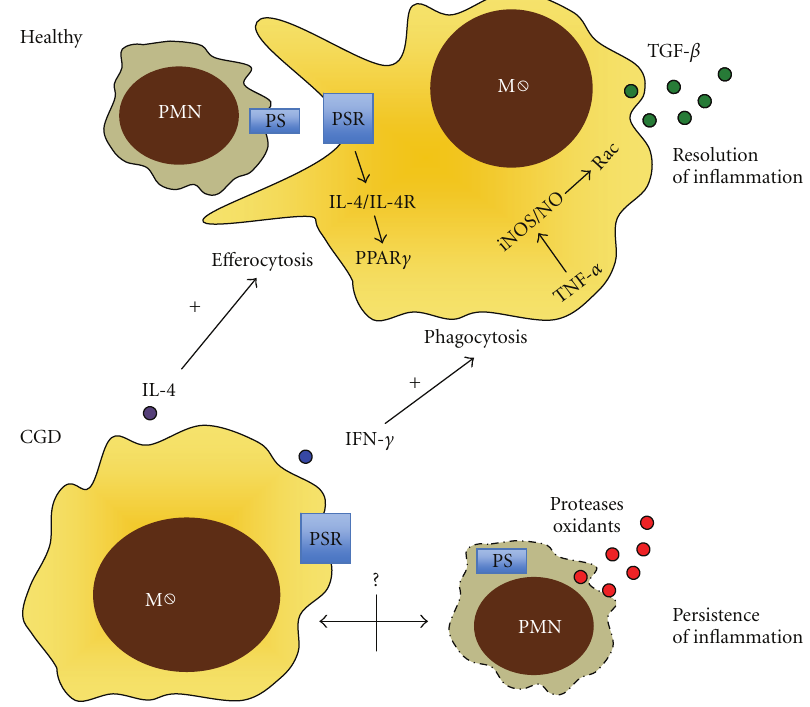
Figure 1: Impaired apoptosis/e ff erocytosis underlying hyperinflammation in CGD. Apoptotic cells (here shown for neutrophils, PMN) externalize phosphatidylserine (PS), which is recognized through PS-receptors on macrophages. This interaction enables the uptake of apoptotic cells by macrophages, a process termed “e ff erocytosis”. Successful e ff erocytosis leads to the secretion of the anti-inflammatory cytokine TGF- β by macrophages and thereby facilitates resolution of acute inflammation. Due to an impaired externalization of PS by CGD neutrophils and/or other neutrophil-macrophage interaction mechanisms, both apoptosis and e ff erocytosis have been described to be dysfunctional in CGD. This leads to unbalanced neutrophil necrosis with release of intracellular proteases/oxidants and persistence of (sterile) inflammation. Two pathways have recently been proposed to be involved in this impairment: PS/PSR interactions were found to trigger downstream pathways comprising IL-4 and PPAR γ , which are critically involved in the regulation of e ff erocytosis. Beyond that, impaired phagocytosis of apoptotic cells by CGD macrophages could be reversed by IFN- γ treatment, an e ff ect that was mediated through NO production, endogenous TNF- α production, and Rac